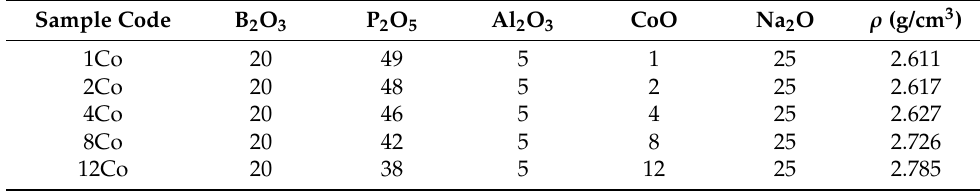
Table 1. Chemical composition (mol.%) and density ( ρ ) of